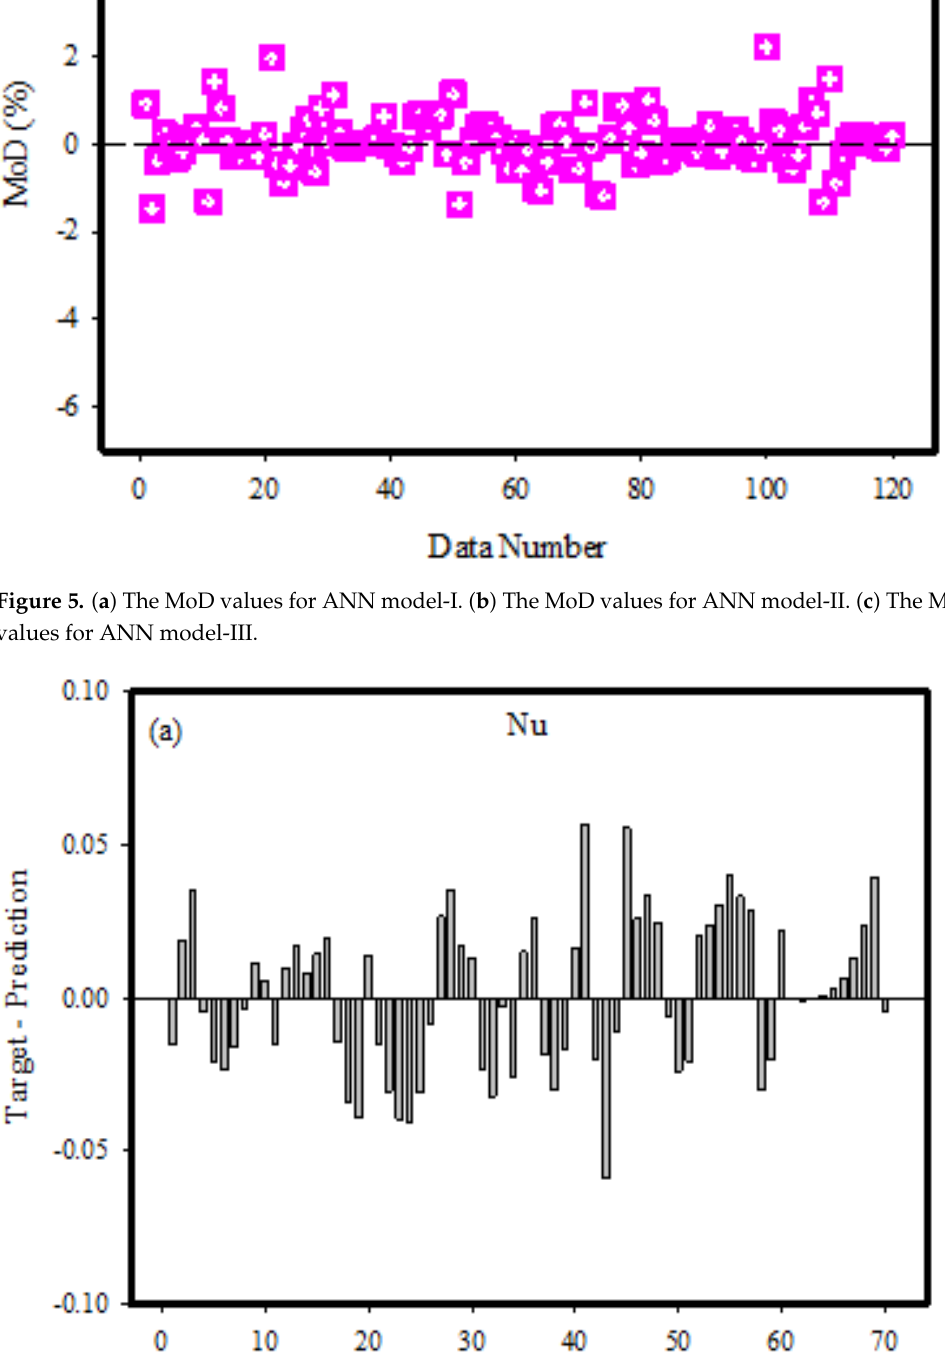
Table 23. Comparison of Nusselt number with Hayat et al. [31].